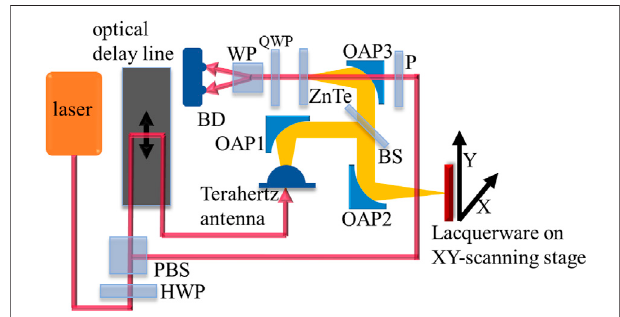
FIGURE 1 | Schematic of the experimental setup of the proposed THz- TDSRI system. HWP: Half-wave plate. PBS: Polarizing beam splitter. BS: THz beam splitter. P: Polarizer. QWP: Quarter-wave plate. WP: Wollaston prism. BD: Balance detector. OAP1, OAP2, OAP3: Off-axis parabolic